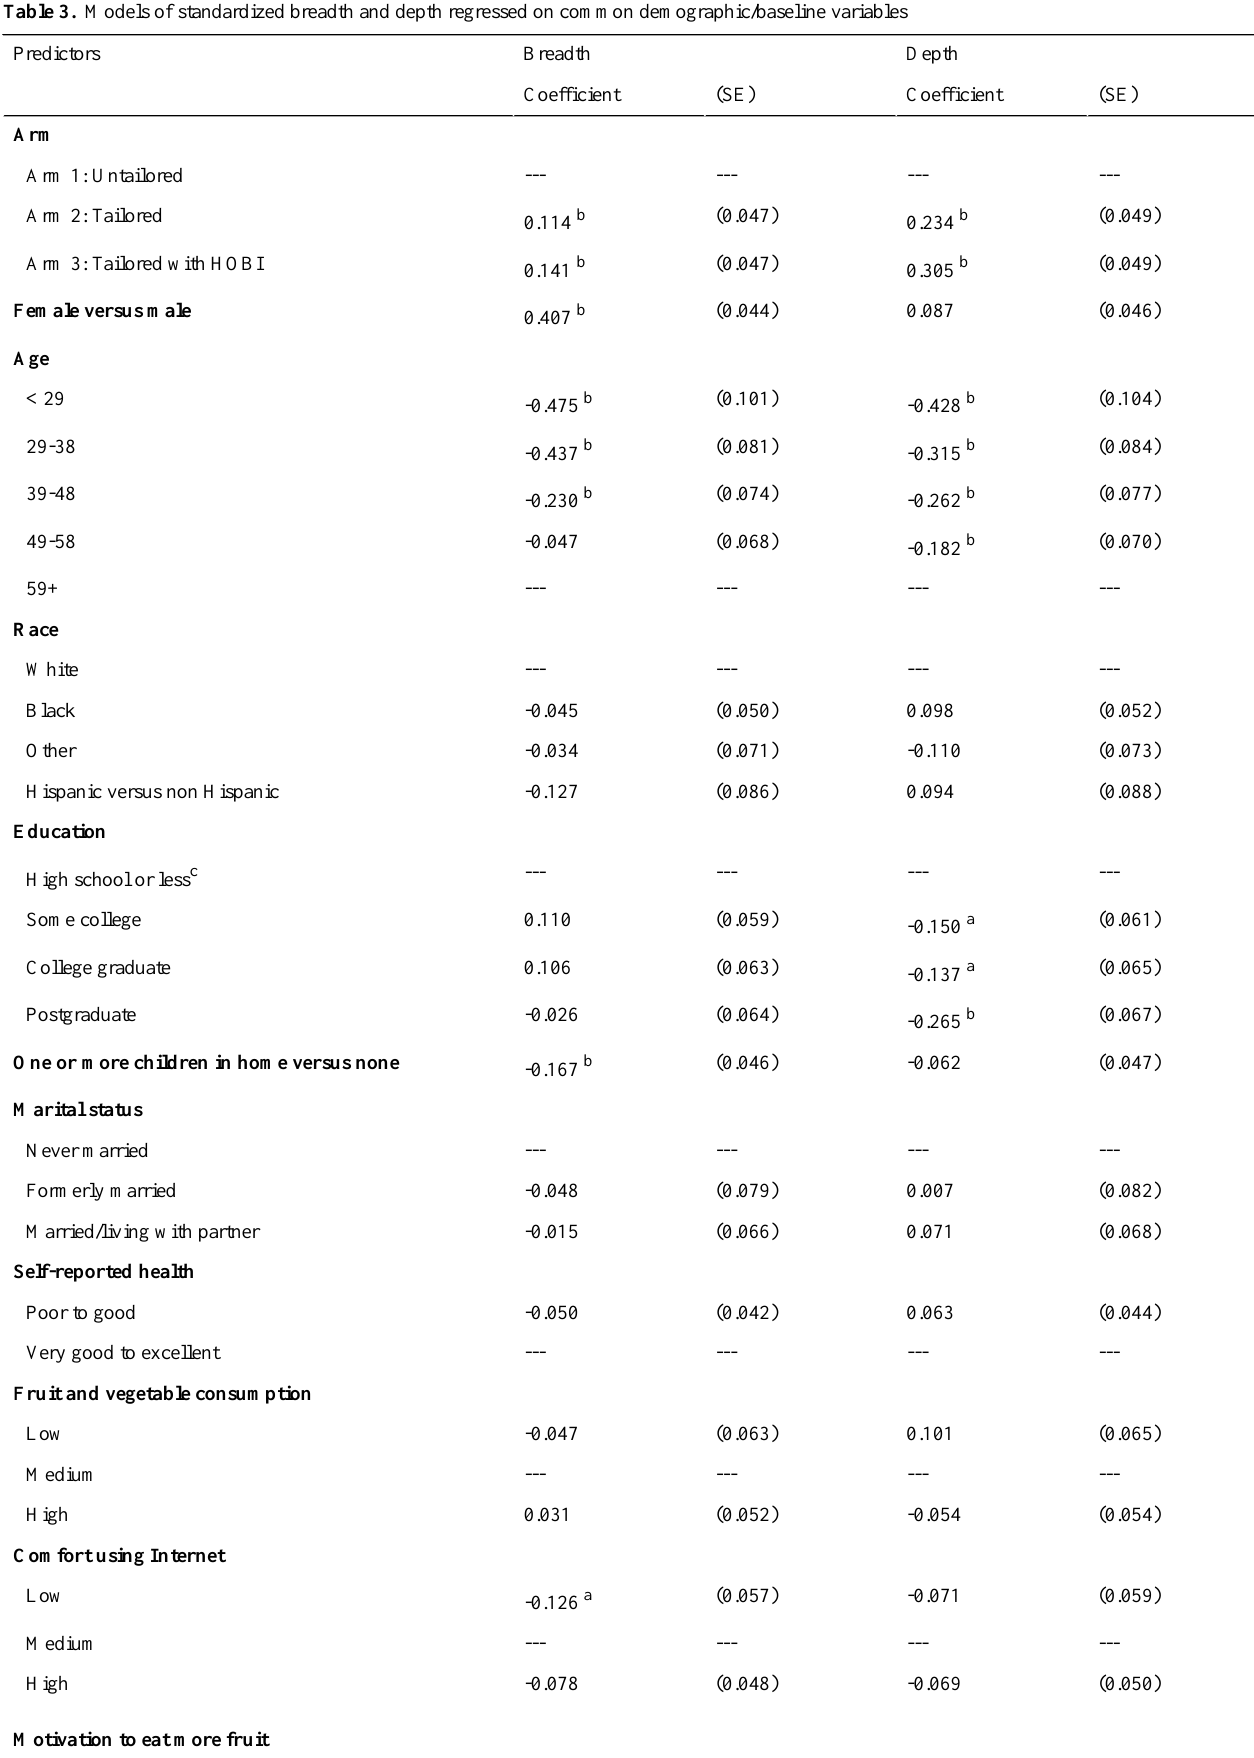
Table 3. Models of standardized breadth and depth regressed on common demographic/baseline